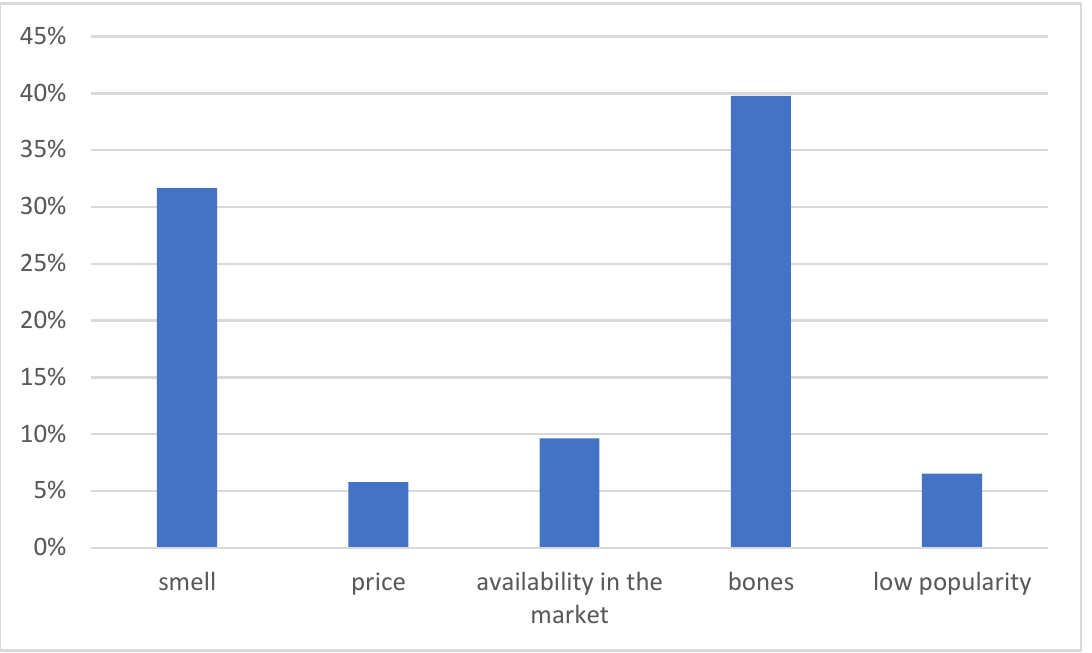
Figure 5. Factors discouraging the consumption of carp among the Young Adult Populations. Source: own elaboration based on data of [43].